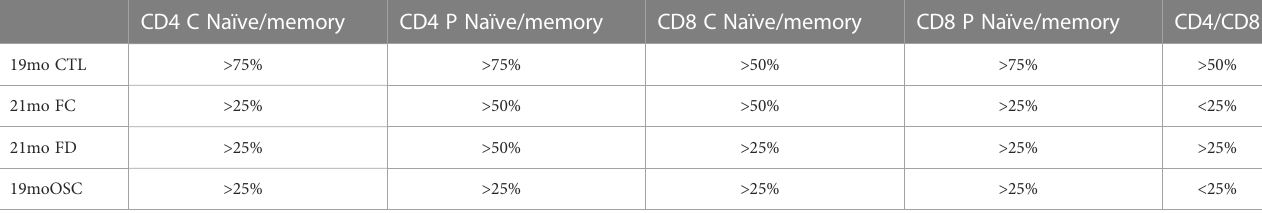
TABLE 2 Percent decrease of T cell ratios from 6 month mice-treatment